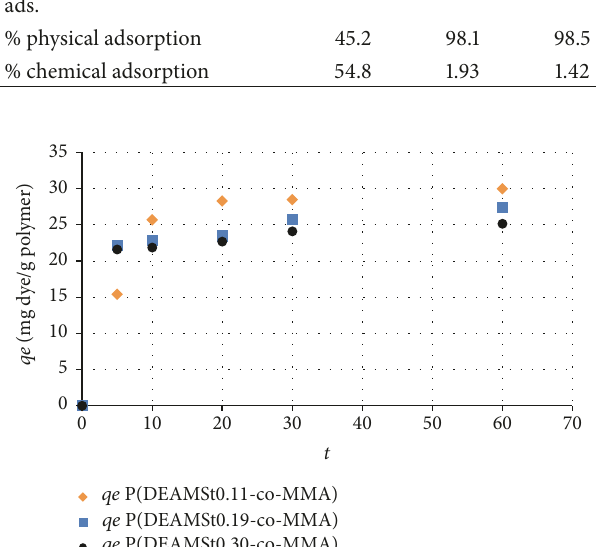
Figure 9: The time change depending on dye uptake quantity of